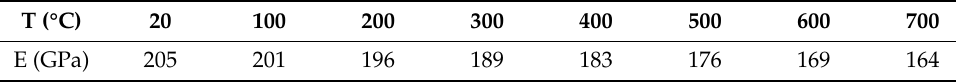
Table 2. GH4169 alloy elastic modulus.